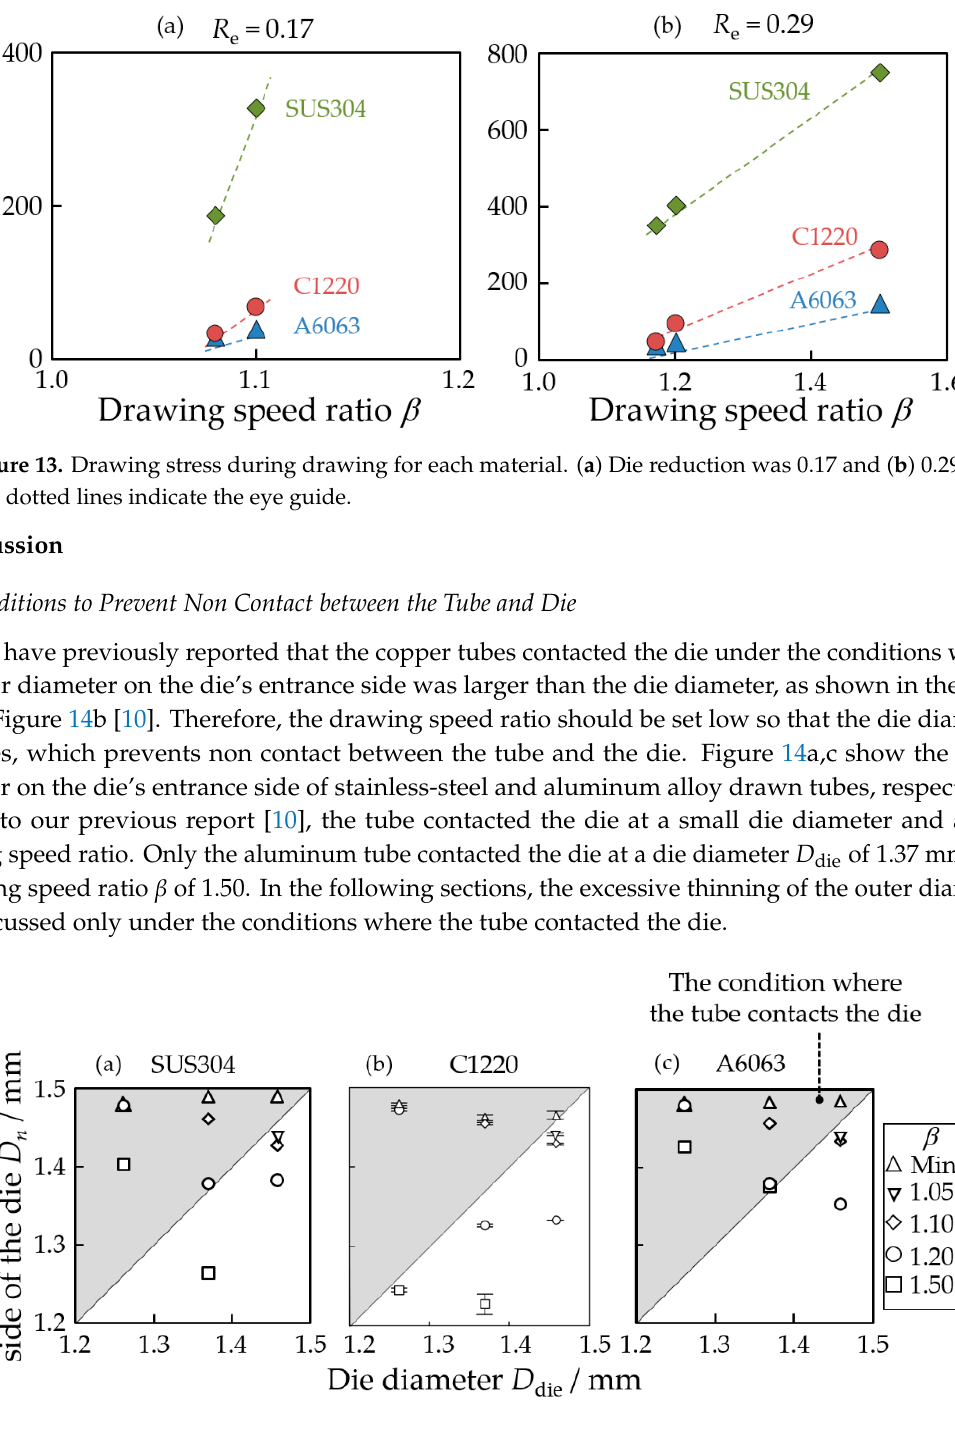
Figure 12. Load during drawing of the copper tube at the die reduction R e of 0.17 and the drawing speed ratio β of 1.10.